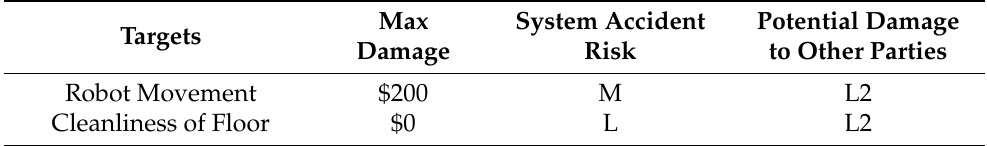
Table 10. System risks for